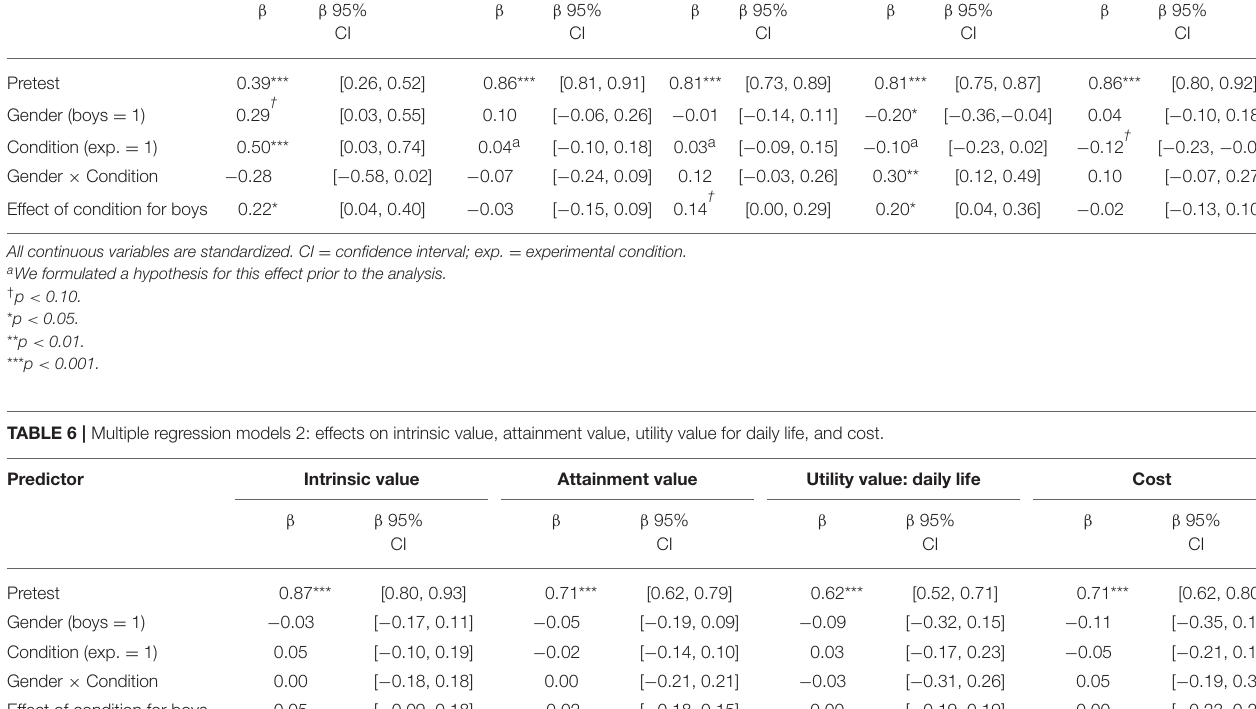
Condition (exp. = 1)